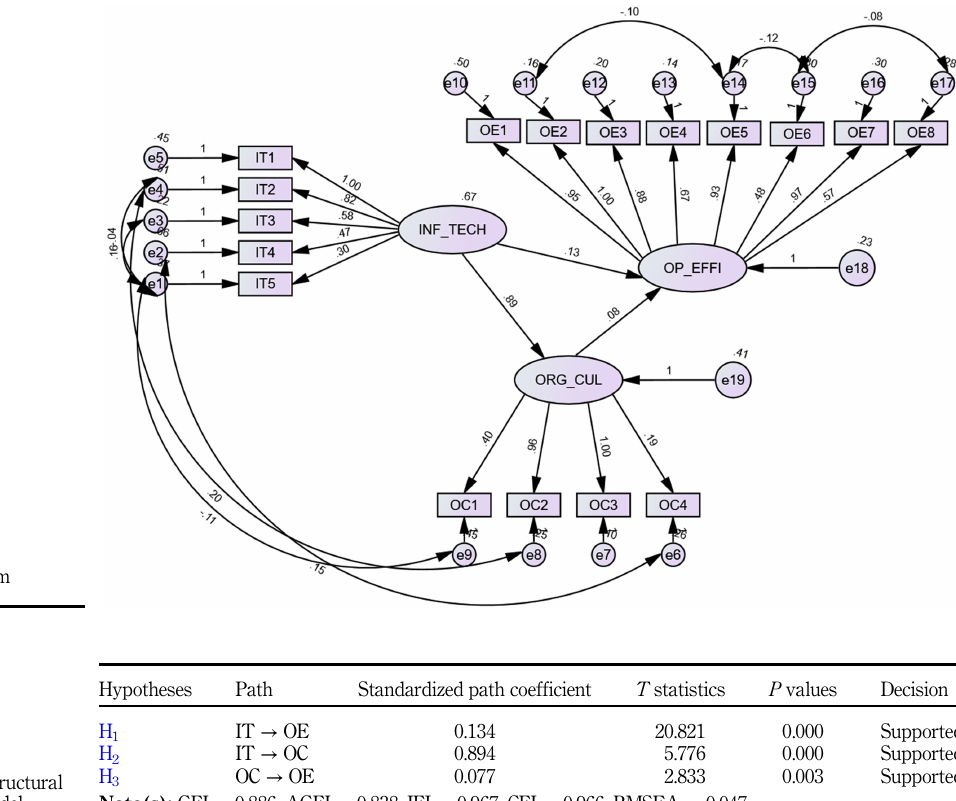
Table 6. Result for structural equation